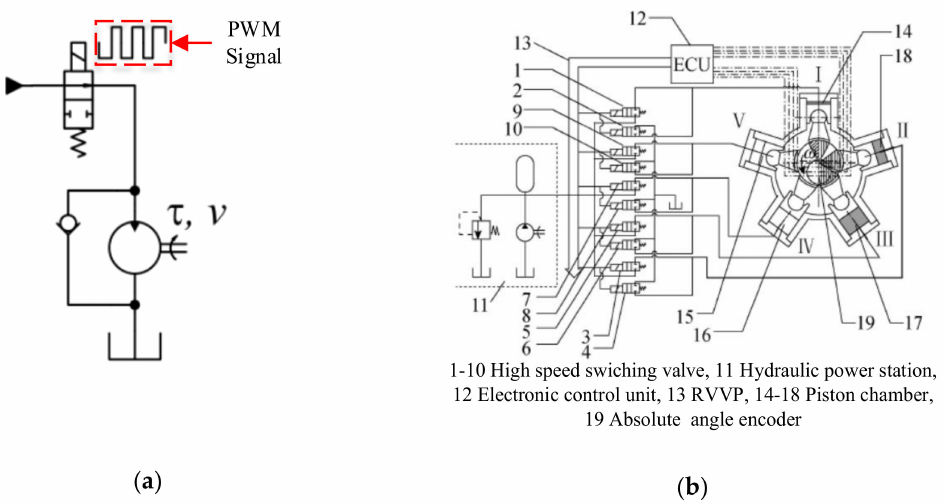
Figure 16. Hydraulic motors each controlled by a high-speed switching valve: ( a ) high-speed switching digital hydraulic motor; ( b ) flow distribution digital hydraulic motor with low speed and high torque.